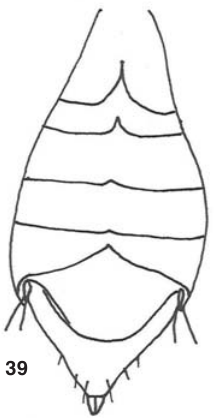
Figure 39. Anastatus mantoidae Motschulsky Female 39 - Metasoma dorsal